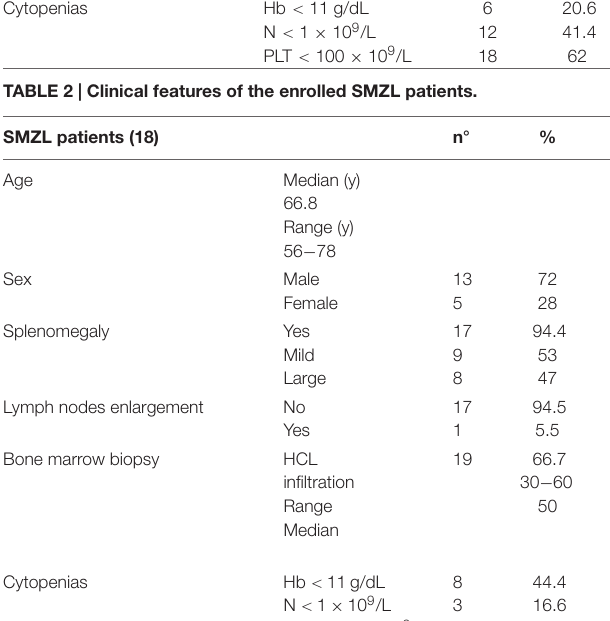
TABLE 2 | Clinical features of the enrolled SMZL